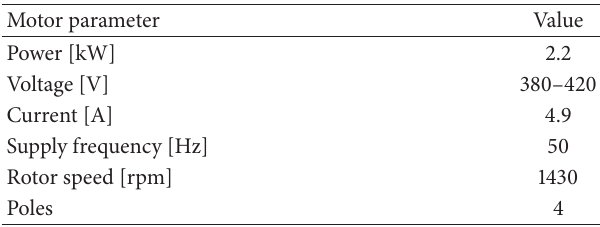
Table 1: Induction motor parameters.